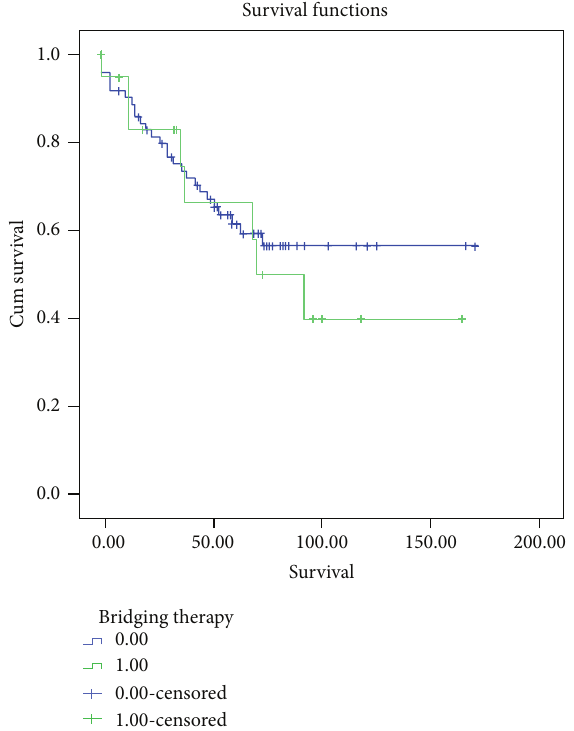
Figure2:Thisgraphicdemonstratessurvivalamongpatientsunder- going LT with and without bridging treatment. Similar survival rates were observed in patients transplanted with and without BT ( 𝑃 = ns). Table 2: Comparison of patients, characteristics. Comparison of patients’